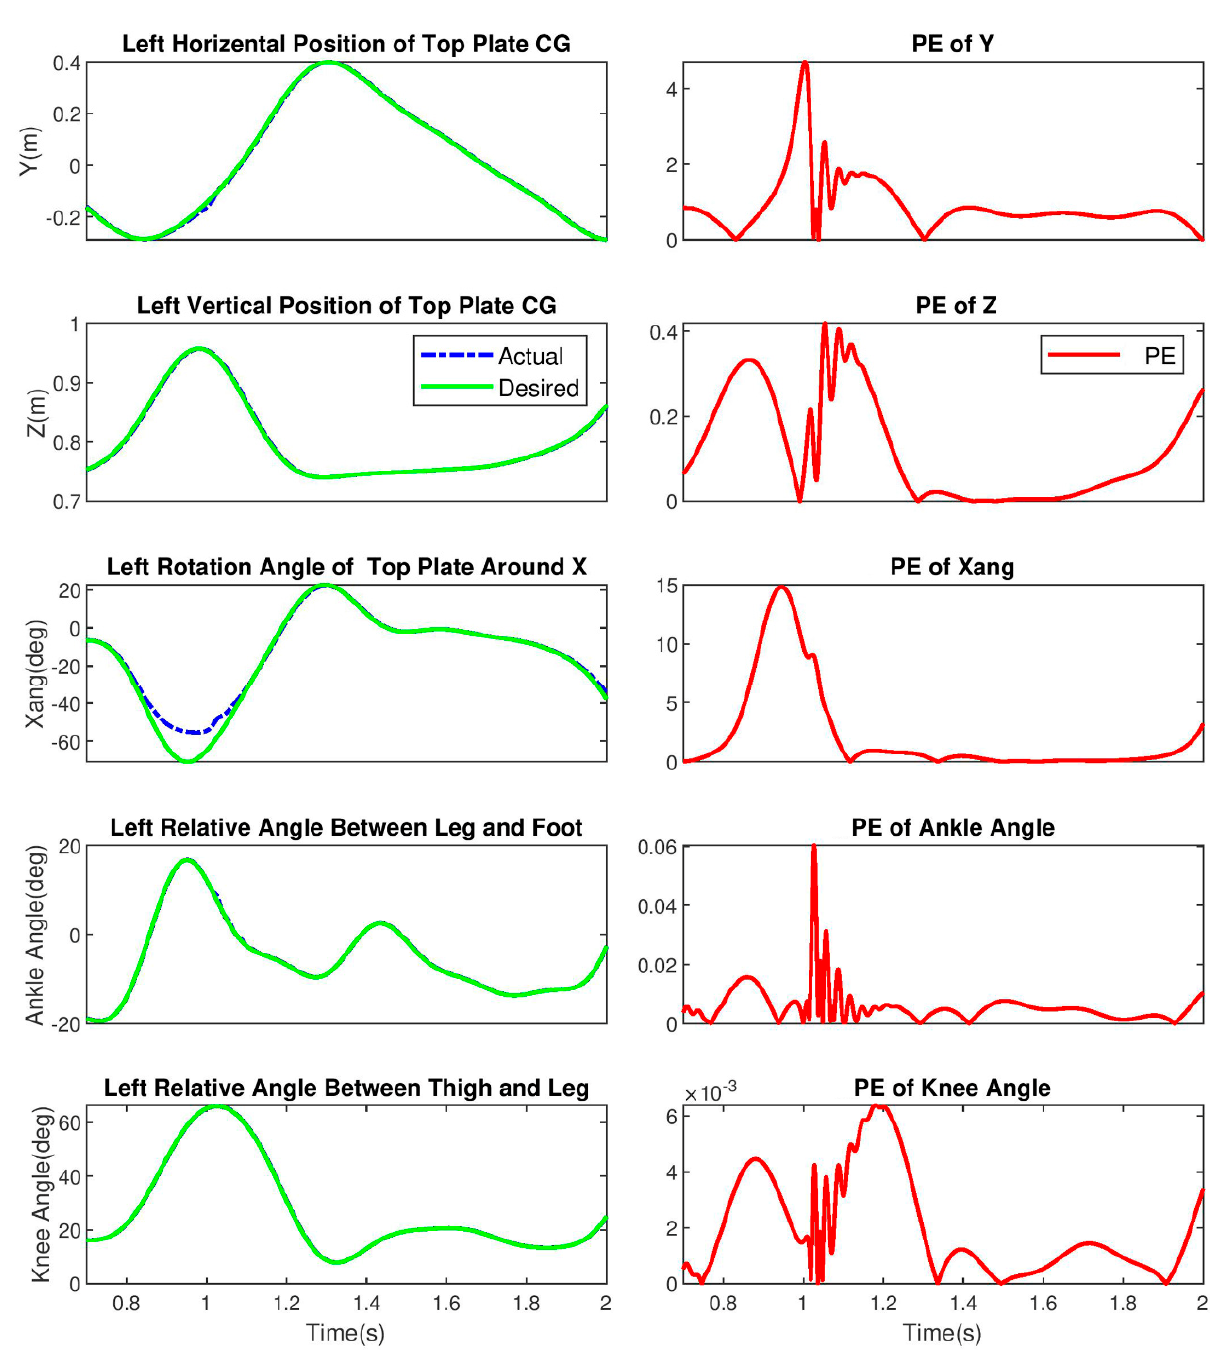
Figure 3. Right-sided column shows the left horizontal and vertical positions and rotation angle of the top plate as well as the relative angle between the leg-foot and thigh-leg. Left-sided column shows the percentage errors between the desired and actual variables presented right-sided column. The 1st, 2nd, 3rd, 4th, 5th, and 6th leg length errors versus time for the left legs were calculated and plotted in Figure 5. The results revealed that the order of error is in the range of 0.01 m. choosing the Stewart leg lengths as the input of controller block over the top plat positions and angle would cause the advantage of fewer errors in control systems due to a more straightforward